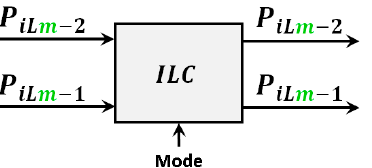
Table 5. Operation modes of the